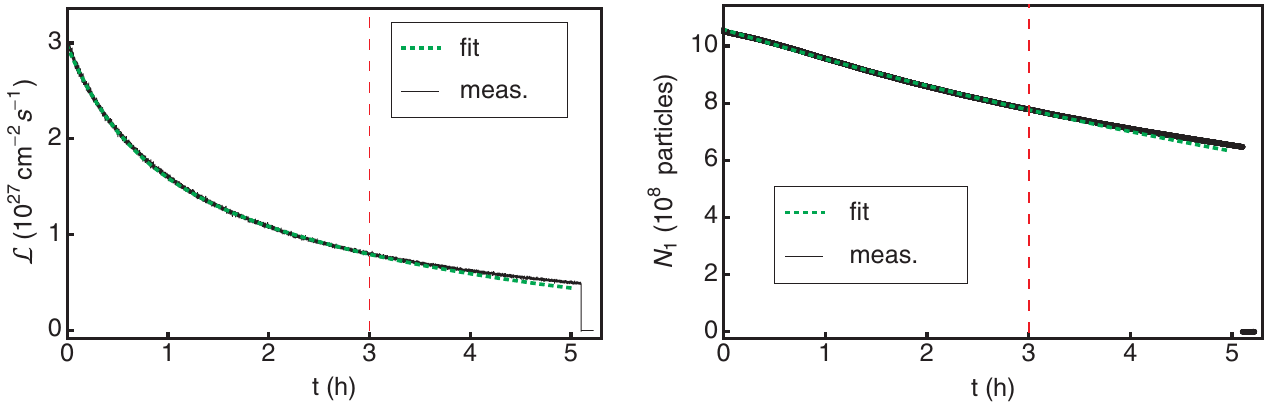
FIG. 3. (Color) A typical example of measured and fitted luminosity (left) and bunch population (right). The fits are done only over the first three hours, indicated by the dashed vertical line, as some stores terminate prematurely. The shown fits have (cid:4) 2 = DOF ¼ 1 : 2 and 0.86. The measurement errors were assumed to be 1 : 4 (cid:4) 10 25 cm (cid:1) 2 s (cid:1) 1 and 2 : 5 (cid:4) 10 6 , respectively, given by the spread of measurement points over a short time